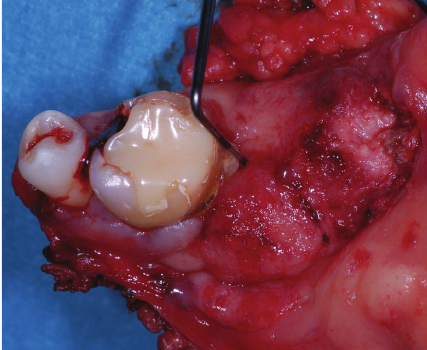
Figure 1: Case 1—resection specimen of the mandible. The probe reveals the loss of clinical attachment within the periodontal space, and the tumor seems to emerge from the periodontal compartment.